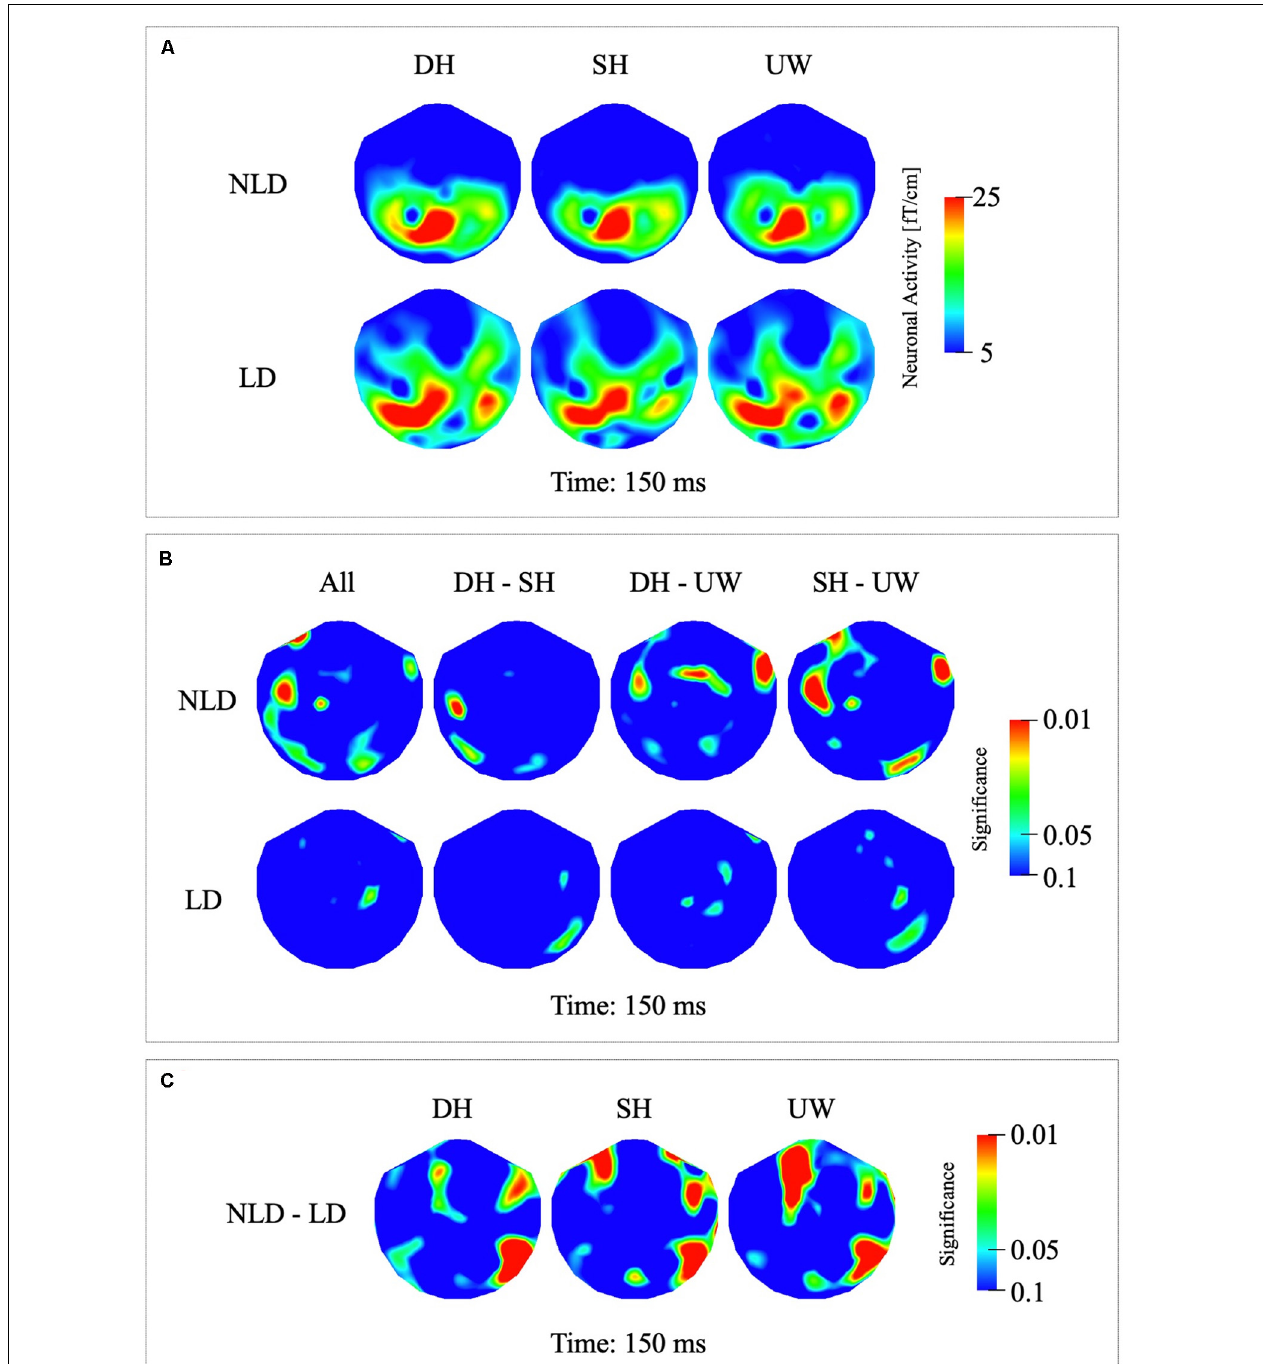
FIGURE 3 | (A) First row: Local RMS-maps for the NLD group’s responses to final words (dominant homonym, subordinate homonym, and unambiguous word) at 150 ms. Second row: Local RMS-maps for the LD group’s responses to final words (dominant homonym, subordinate homonym, and unambiguous word) at 150 ms. (B) First row: NLD group’s Friedman analysis result for dominant homonym, subordinate homonym, and unambiguous word at 150 ms. Wilcoxon pairwise analysis result of dominant homonym and subordinate homonym, dominant homonym and unambiguous word, and subordinate homonym and unambiguous word at 150 ms. Second row: LD group’s Friedman analysis result for dominant homonym, subordinate homonym, and unambiguous word at 150 ms. Wilcoxon pairwise analysis result of dominant homonym and subordinate homonym, dominant homonym and unambiguous word, and subordinate homonym and unambiguous word at 150 ms. (C) Mann–Whitney U analysis result for NLD vs. LD groups’ responses to final words (dominant homonym, subordinate homonym, and unambiguous word) at 150 ms. For the presentation of data, the detectors have been projected into two dimensions (right ear on the right, front at the